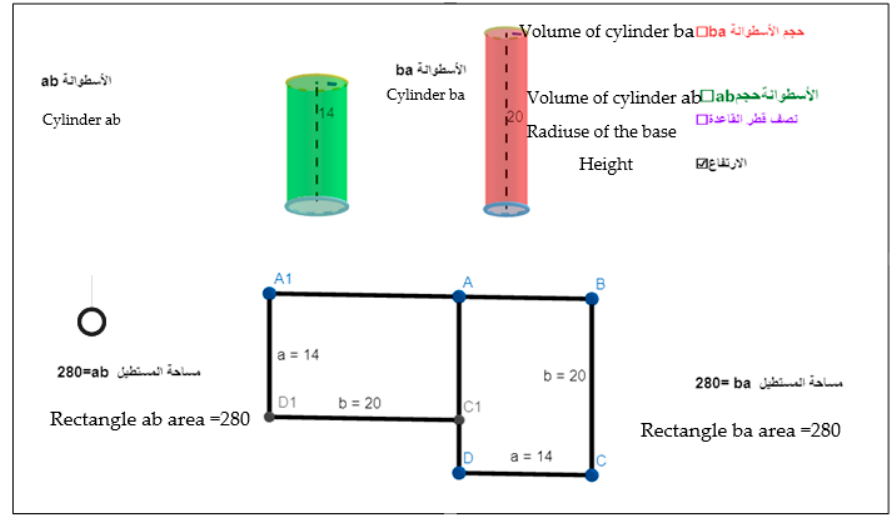
Figure 2. Applet for same surface–same volume.